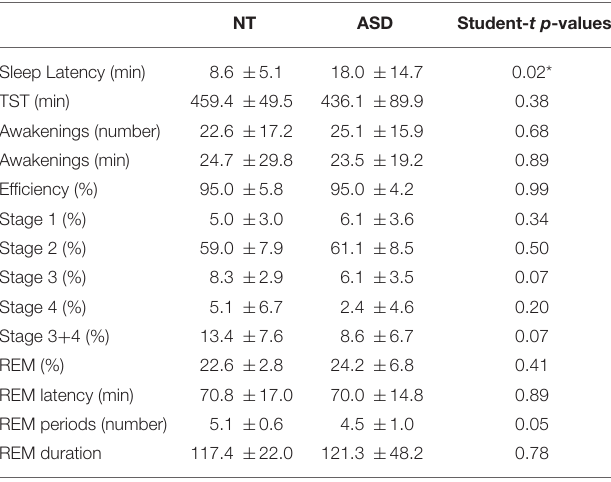
TABLE 2 | Sleep characteristics in 17 young autistic adults (ASD) and 16 neurotypical controls (NT).